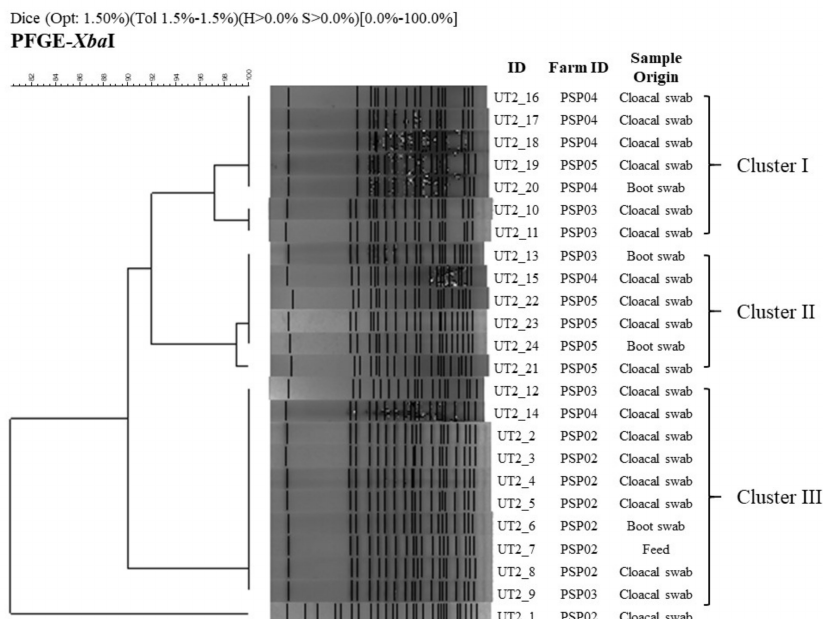
Figure 2. Macrorestriction patterns of 24 Salmonella Paratyphi B generated by pulsed-field gel electrophoresis (PFGE) of XbaI -digested genomic DNA. A similarity analysis was performed using the Dice coefficient, and the dendrogram was generated by the unweighted pair group method with arithmetic averages using the Gel Compare II software (Applied Maths, Sint-Martens-Latem, Belgium). Lanes UT2_1 to UT2_24 correspond to the genomic DNA fingerprinting from each Salmonella isolate from the broiler farms in the Tolima region collected from year 2015 to 2016.